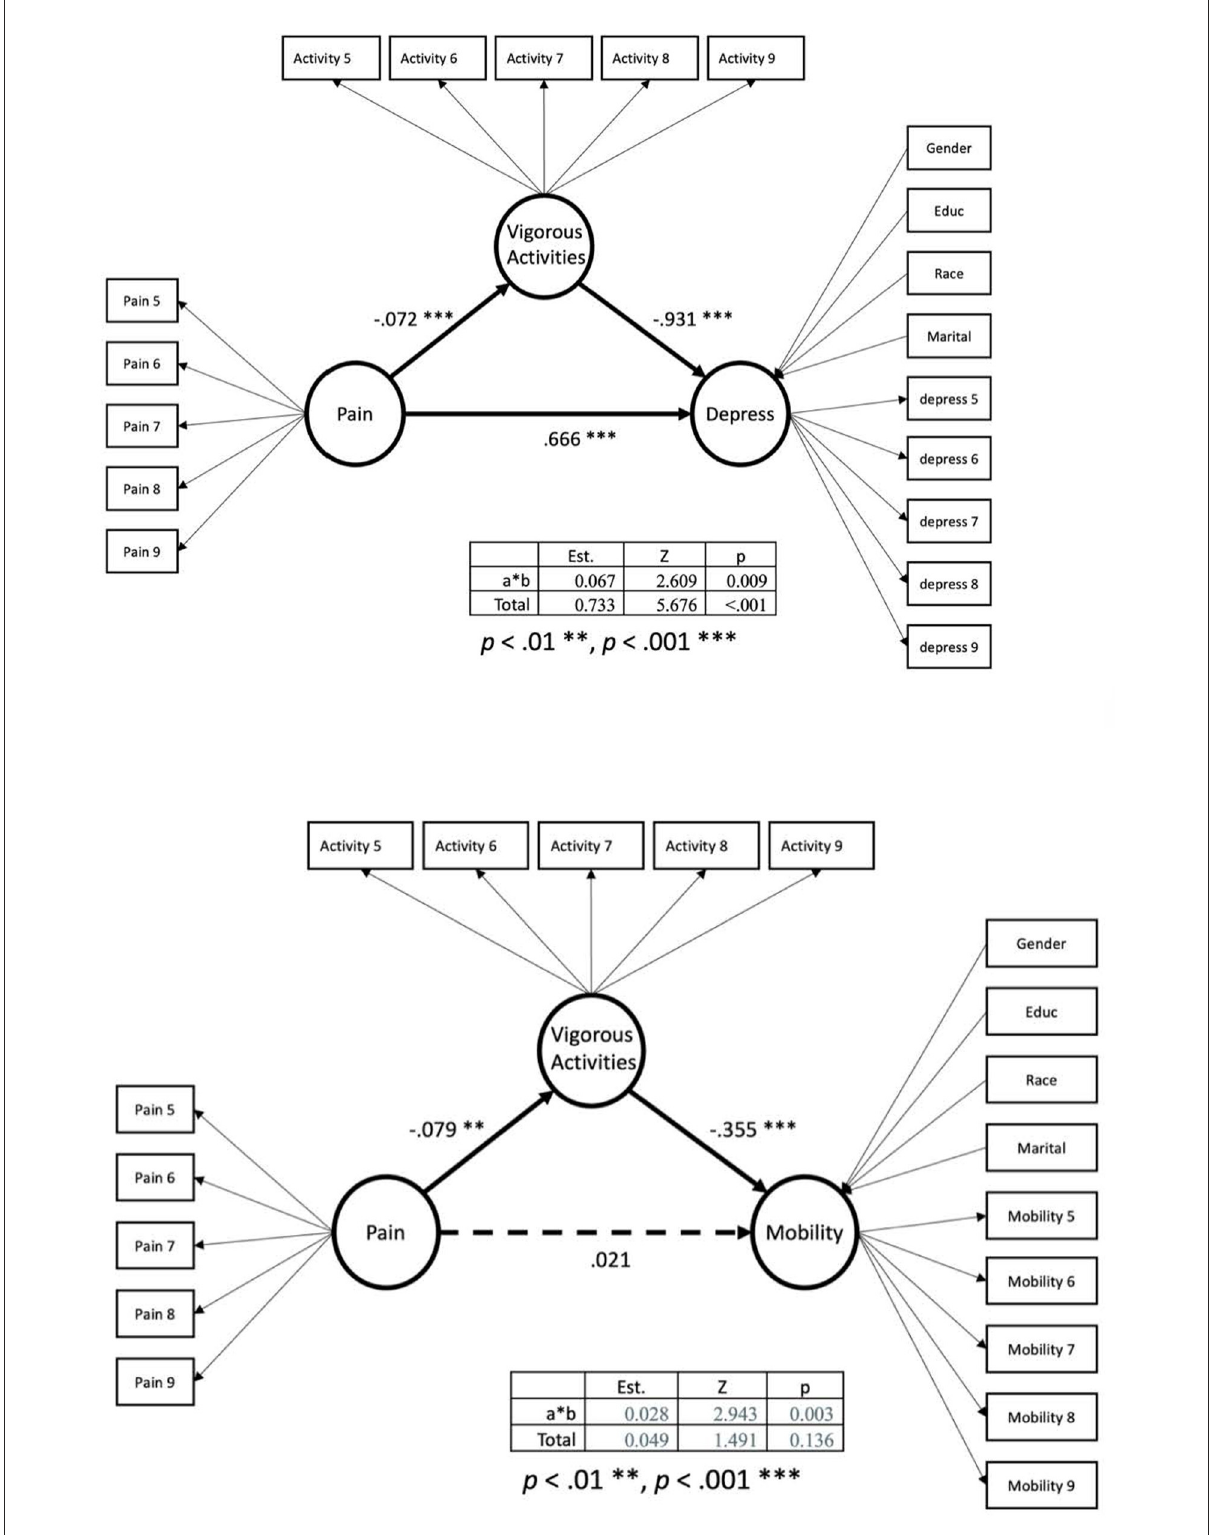
FIGURE1 Mediation model with vigorous activities mediating relationship between pain and